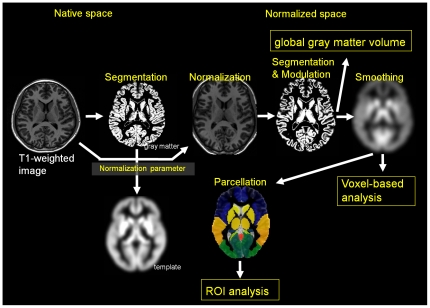
Schema of brain MR image analysis for global and regional gray matter volume.